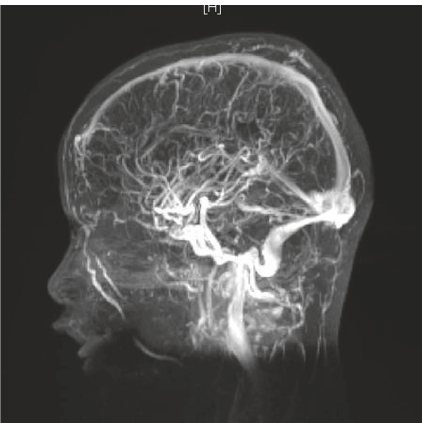
Figure 3: MRV of the brain, showing filling defects in the transverse, sigmoid, and internal jugular